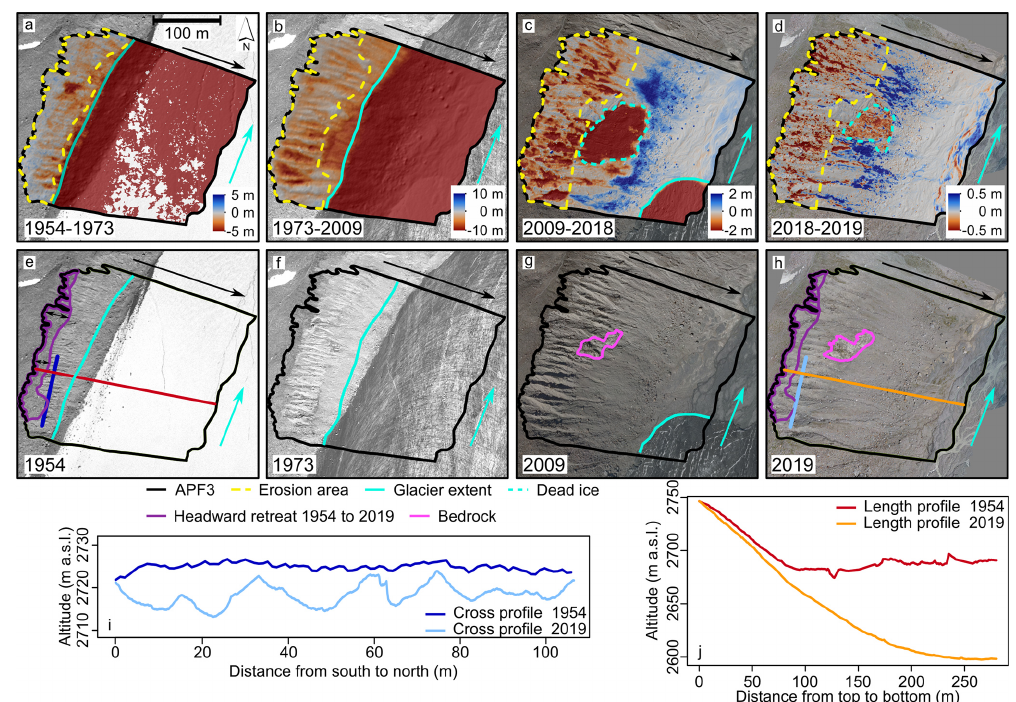
Figure 8. Development of deeply incised gullies for the example of moraine section APF3 in the Alpeiner Ferner forefield: (a–d) DoDs of moraine section APF3 for 1954–1973, 1973–2009, 2009–2018, and 2018–2019, with markings showing the erosion area (dotted yellow line), glacier extent (cyan line), glacier flow direction (cyan arrow), and dead ice (dotted cyan line) and black arrows indicating the downslope direction; (e–h) orthophotos of APF3 for 1954, 1973, 2009, and 2019, with lines showing the length (blue) and cross profiles (red/orange) and a bedrock outcrop (magenta); (i) cross profiles through APF3 for 1954 and 2019; and (j) length profiles along APF3 for 1954 and 2019 (the aerial images of 1954 are from BEV, and those from 1973 and 2009 are from the State of Tyrol,